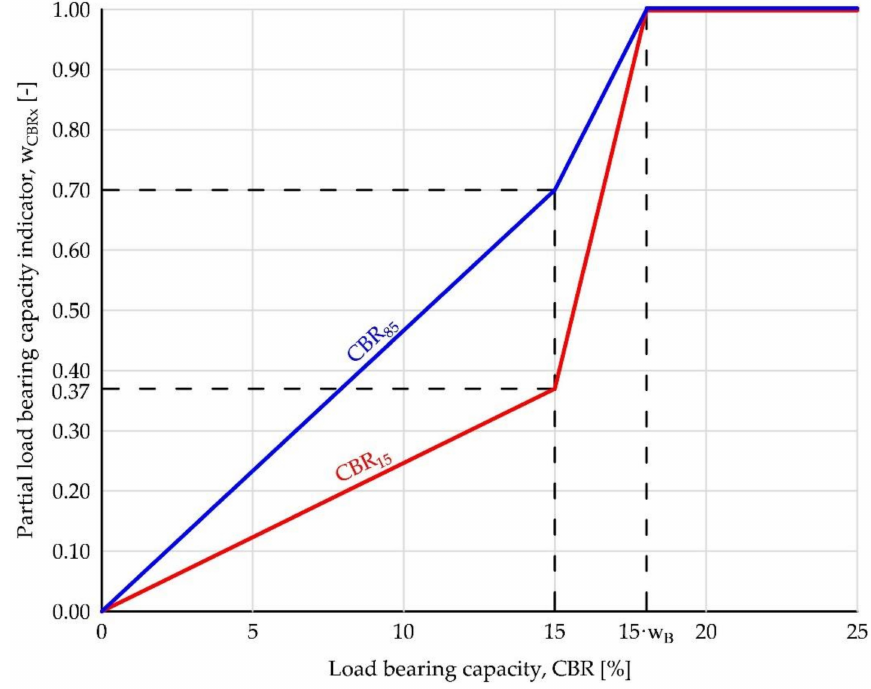
Figure 6. Nomogram for reading the partial load capacity of the airfield pavements: CBR 15 —curve for intermediate layer 0 ÷ 15 cm, CBR 85 —curve for intermediate layer 15 ÷ 85 cm, W B —safety coefficient ( W B = 1.2).